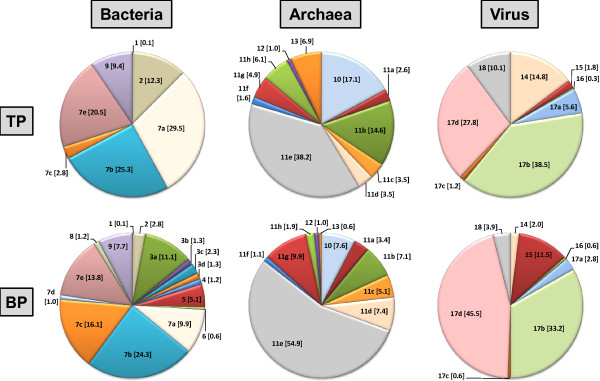
Distribution of the Bacteria, Archaea and Virus domain as determined by taxonomic identification at class level of annotated proteins. Numbers in brackets represent percentage of each group from the total number of sequences. Bacteria domain: 1. unclassified, 2. Actinobacteria, 3a. Bacteroidia, 3b. Cytophagia, 3c. Flavobacteria, 3d. Sphingobacteria, 4. Chlorobia, 5. Clostridia, 6. Fusobacteria, 7a. Alphaproteobacteria, 7b. Betaproteobacteria, 7c. Deltaproteobacteria, 7d. Epsilonproteobacteria, 7e. Gammaproteobacteria, 8. Synergistia, and 9. other classes each representing <1%. Archaea domain: 10. Thermoprotei, 11a. Archaeoglobi, 11b. Halobacteria, 11c. Methanobacteria, 11d. Methanococci, 11e. Methanomicrobia, 11f. Methanopyri, 11g. Thermococci, 11h. Thermoplasmata, 12. Korarchaeota [phylum] and 13. Thaumarchaeota [phylum]. Phage (host): 14. Actinobacteria, 15. Bacilli, 16. Cyanobacteria, 17a. Alphaproteobacteria, 17b. Betaproteobacteria, 17c. Deltaproteobacteria, 17d. Gammaproteobacteria and 18. other classes each representing <1%. Groups (phylum): 3. Bacteroidetes, 7. and 17. Proteobacteria, 10. Crenarchaeota, 11. Euryarchaeota.